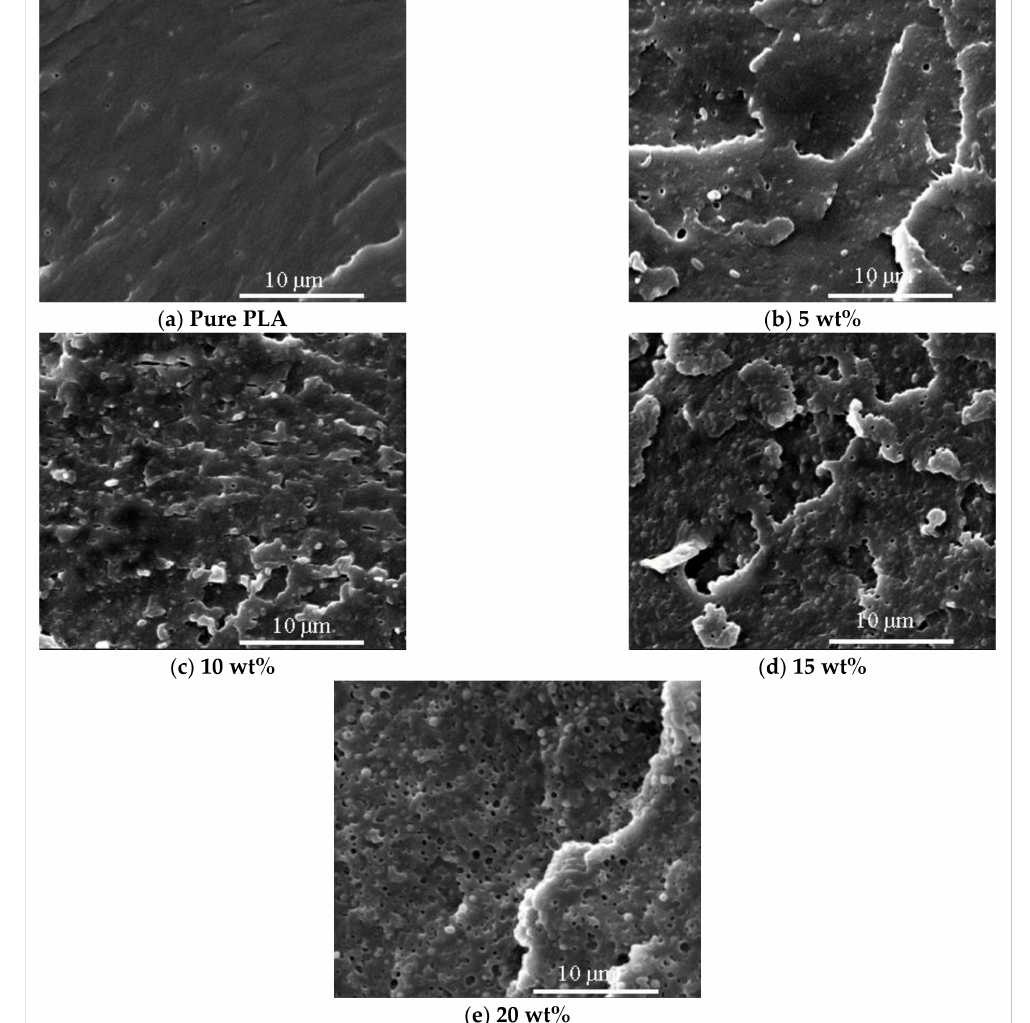
Figure 12. Scanning electron microscopy (SEM) photographs of cross section of PLA/TPSiU blends with different TP- SiU